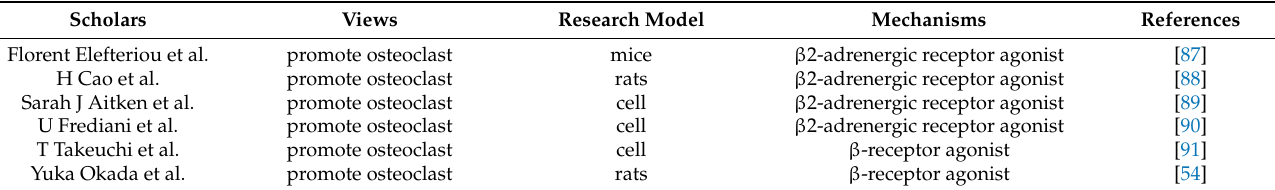
Table 2. Sympathetic regulation of